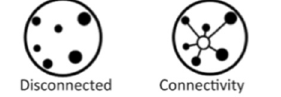
Figure 12. Promote Connectivity and Minimize Isolation.